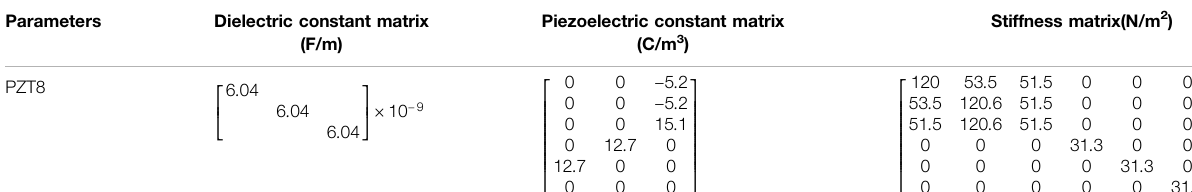
TABLE 1 | Parameters of piezoelectric ceramics. Parameters Dielectric constant matrix